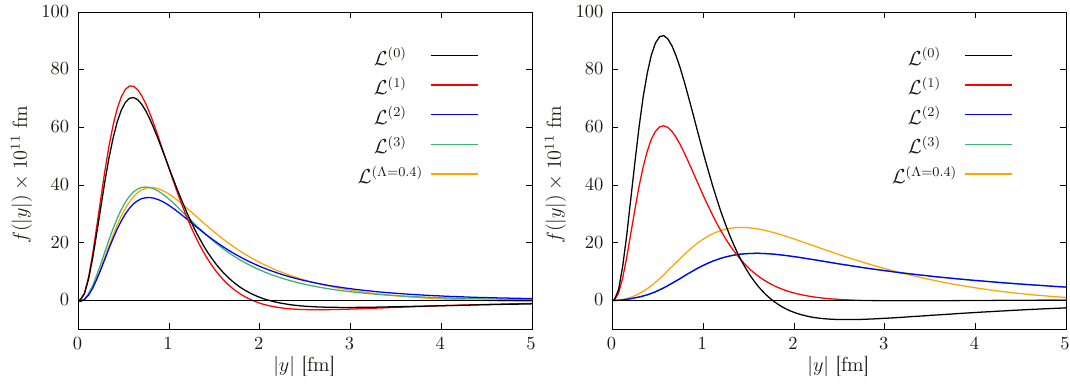
Figure 7 . The integrand with respect to the variable | y | leading to a HLbL with a VMD form factor and a pion mass of 135 MeV. The integrals over | x | and cos β have already been performed at this stage. The different curves correspond to the kernels introduced in eq. (8.1) and eq. (8.4). Left: Method 1. Right: Method 2. Note that for method 2, the kernel L (2) and L (3) yield identical